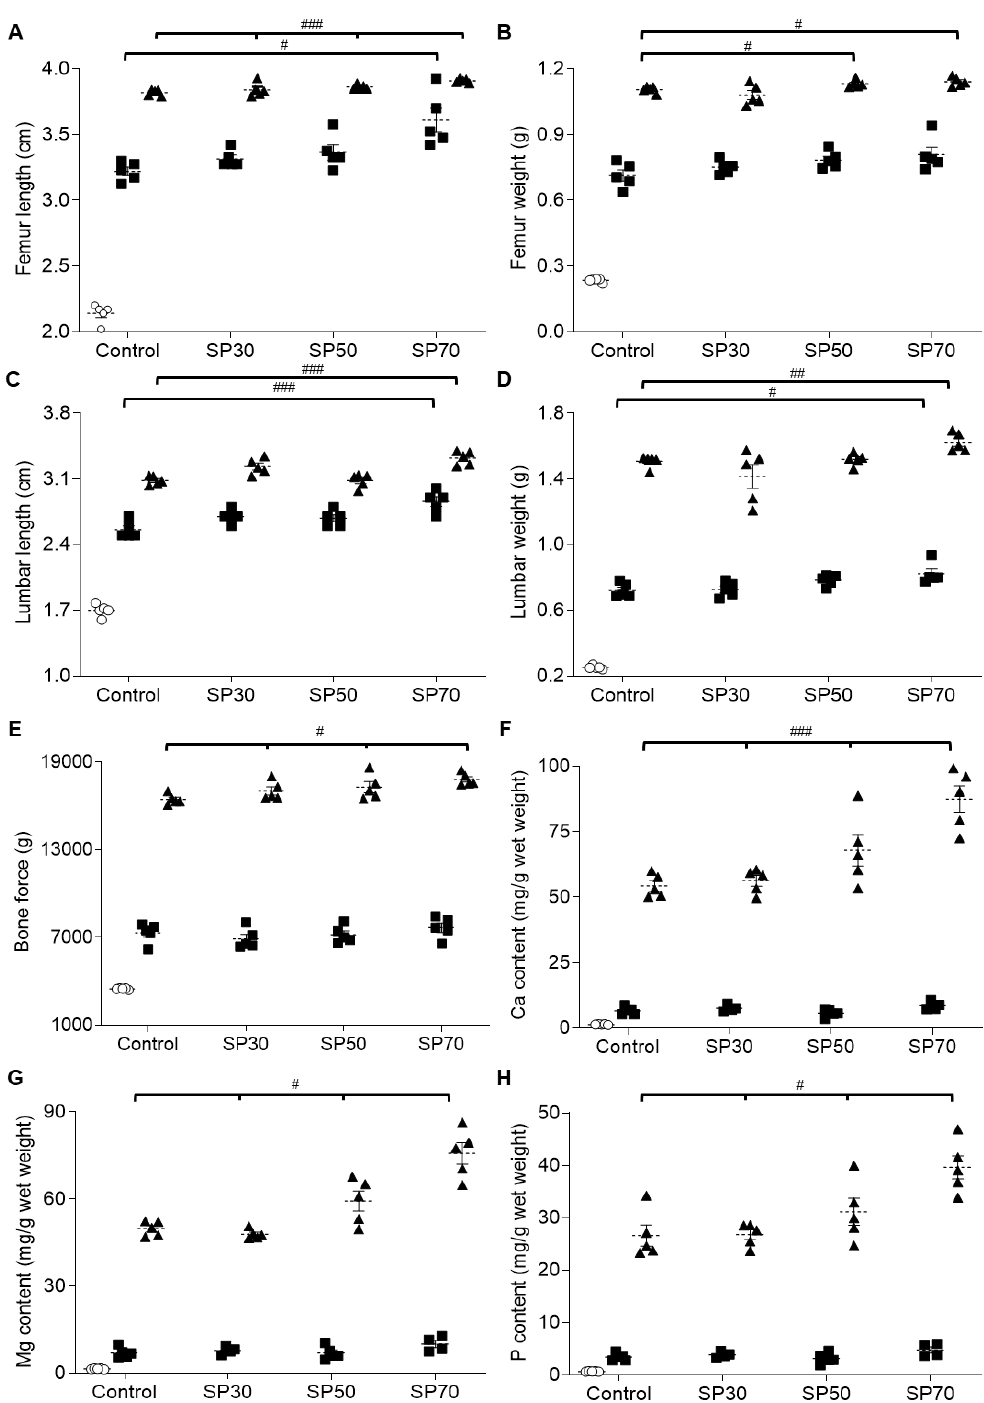
Figure 2. E ff ect of spirulina on bone growth, bone strength, and bone mineral content (BMC). ( A ) Femur length, ( B ) femur weight, ( C ) lumbar spine length, ( D ) lumbar spine weight, ( E ) breaking force of femur, ( F ) Ca content of femur, ( G ) Mg content of femur, and ( H ) phosphate content of femur were measured in growing male rats over the 7-week course of the study. Data are mean ± SEM values. Significant di ff erences were determined using t -tests or one-way ANOVA with post hoc Duncan’s multiple-range test comparisons. # p < 0.05, ## p < 0.01, or ### p < 0.001 between groups in the same week. Control: AIN 93G diet; SP30: 30% of protein source replaced with spirulina; SP50: 50% of protein source replaced with spirulina; SP70: 70% of protein source replaced with spirulina. The week of the treatment is represented by O: 0 weeks; (cid:4) : 3 weeks; (cid:78) : 7 weeks in each